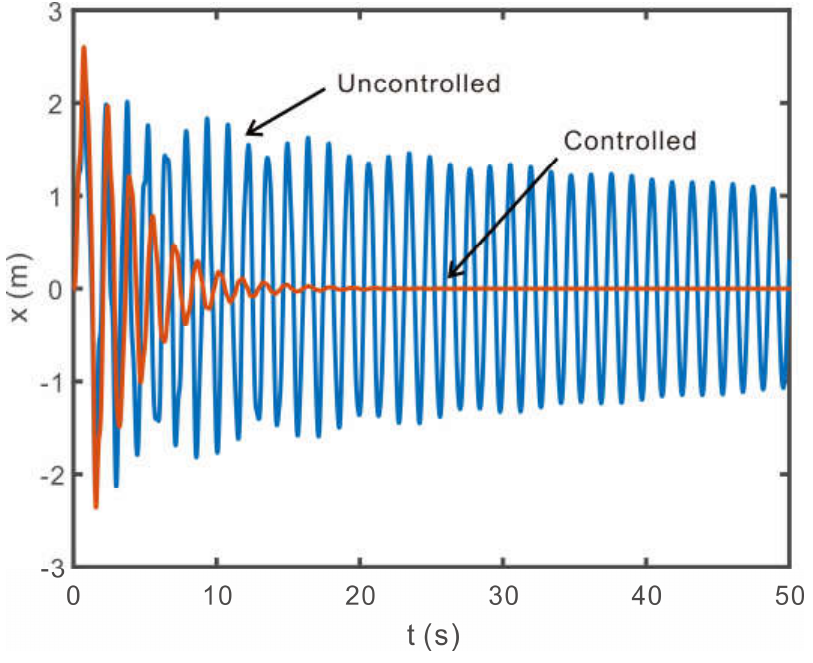
Figure 14. Free vibration experiment (the first mode excited).